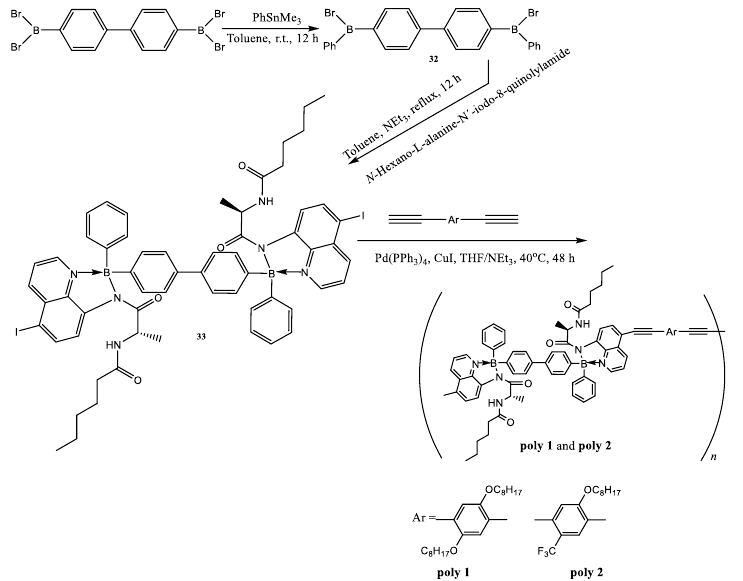
Scheme 6. Synthesis of organoboron aminoquinolate-based coordination polymers.